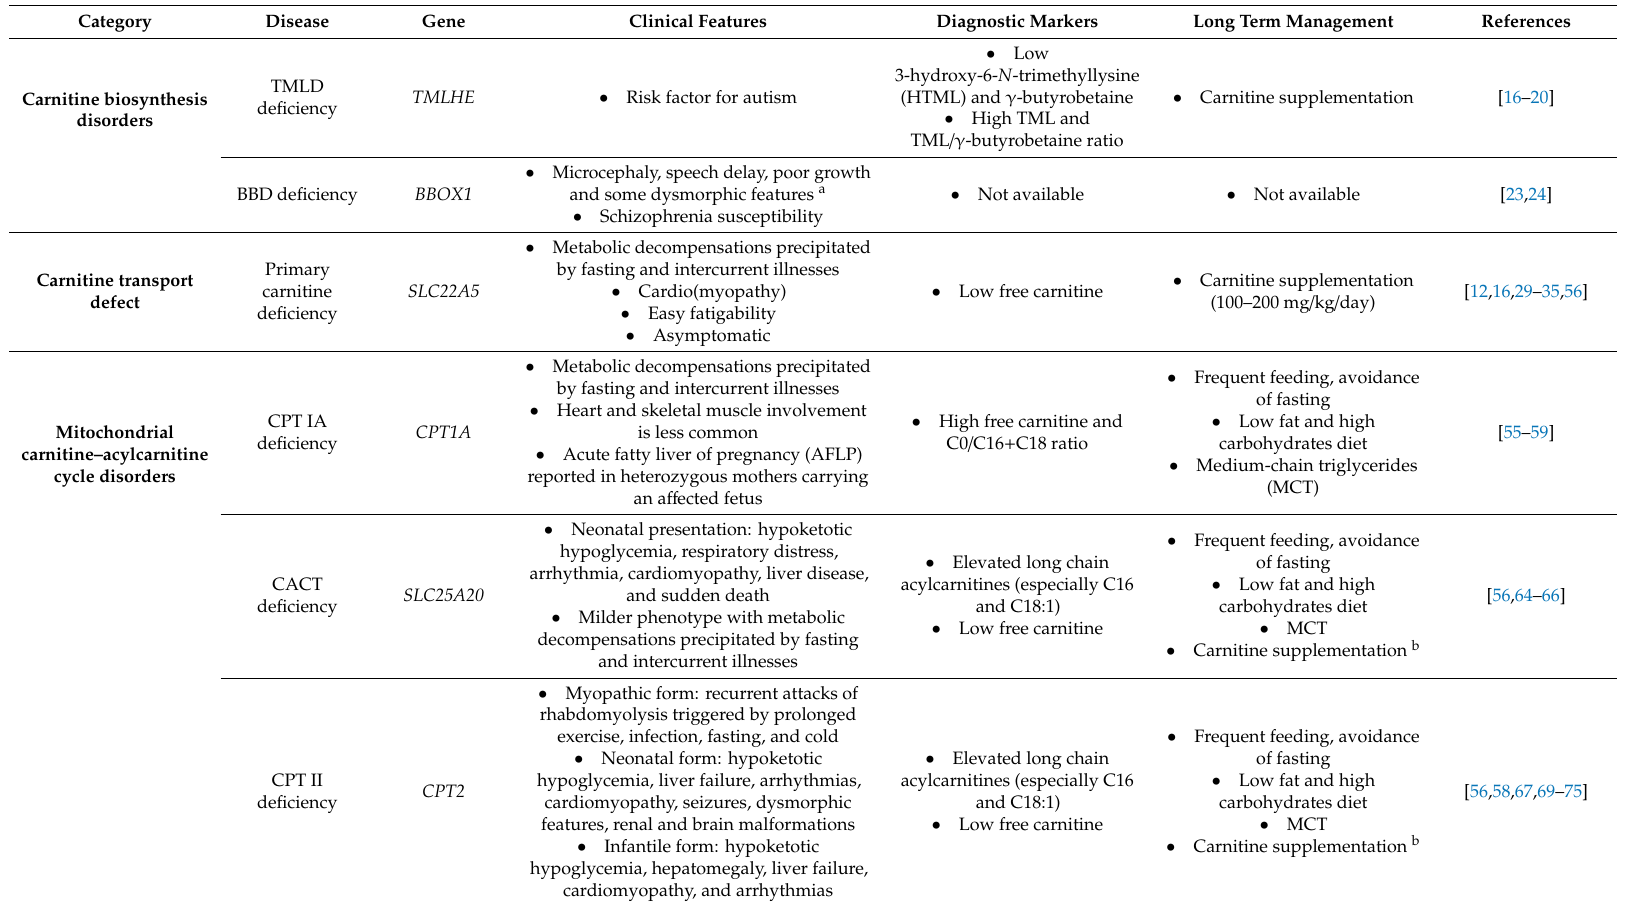
Table 1. Summary of inborn errors of carnitine